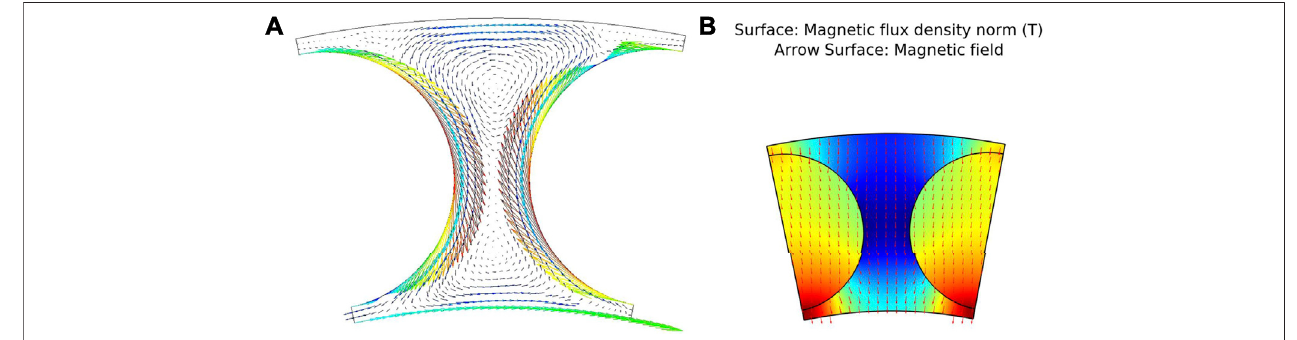
FIGURE 4 | Structure of a planetary MRTD. (A) Principle diagram of the planetary MRTD and (B) image of the planetary MRTD.